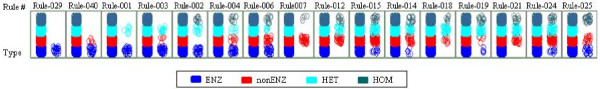
A scatter Plot matrix for PPI types and association rules. This scatter plot matrix shows clusters as collection of points separated by association rules encoding SSE content information or a SCOP class. Different colors of the left in each plot (a cell) correspond to four PPI types. The right of a plot area presents the distribution of points met with a rule on the head of a cell. Rules 29, 40, 1, and 3 separate ENZ and nonENZ from other types remarkably with few errors. The Rule 29 is a strong discriminator to classify ENZ from other types completely.